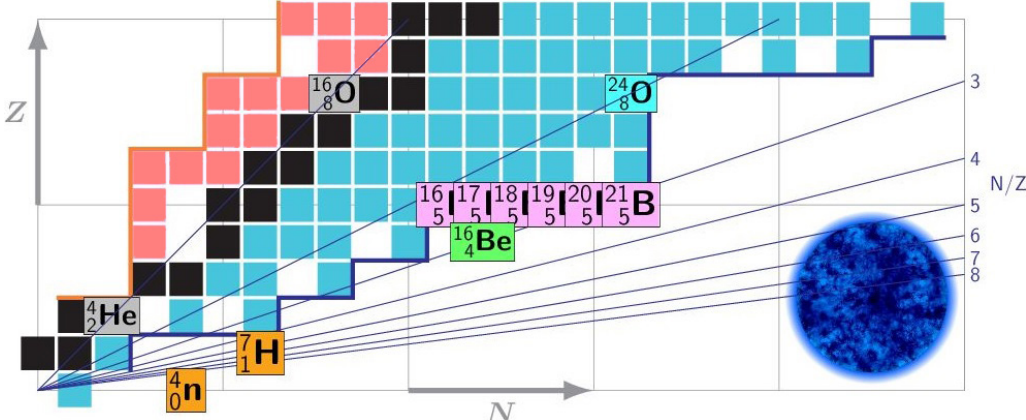
Figure 1: The ( N , Z ) chart of isotopes up to neon ( Z = 10). Stable nuclei are repre- sented by black boxes, and exotic nuclei by red (neutron deficient) and cyan (neutron rich) boxes. The exotic structures discussed in this contribution are highlighted in magenta (boron chain), green (dineutron emission) and orange (multi-neutron sys- tems). For comparison, a neutron star has been placed along the N / Z = 8